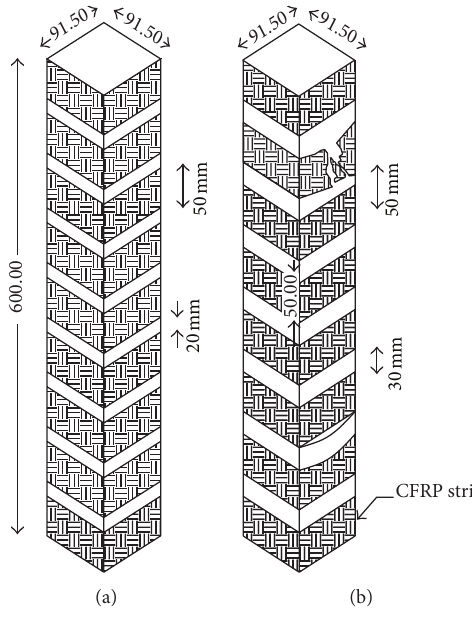
Figure 1: Wrapping Scheme (a) HS-50-20 (b) HS-50-30.